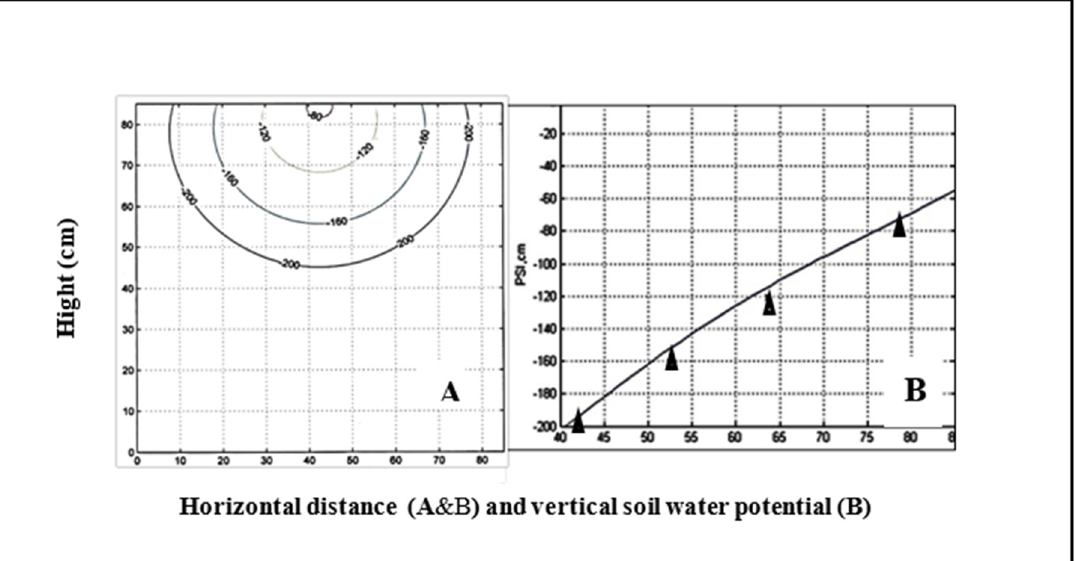
Figure 1. ( A ) Hydraulic head distribution resulting from DI infiltration into Panoche clay loam. ( B ) Vertical cross-section for hydraulic head in the center of ( A ). Triangles are experimental data [20]. Both ( A ) and ( B ) are calculated after 36